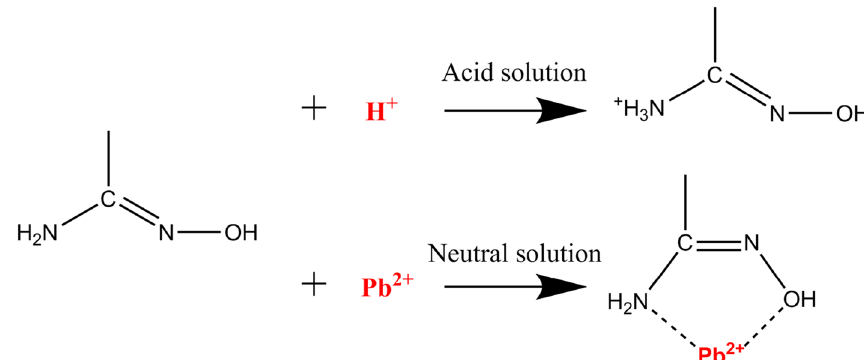
Fig. 8 The reaction of AOPAN/ PVDF in water at different pH